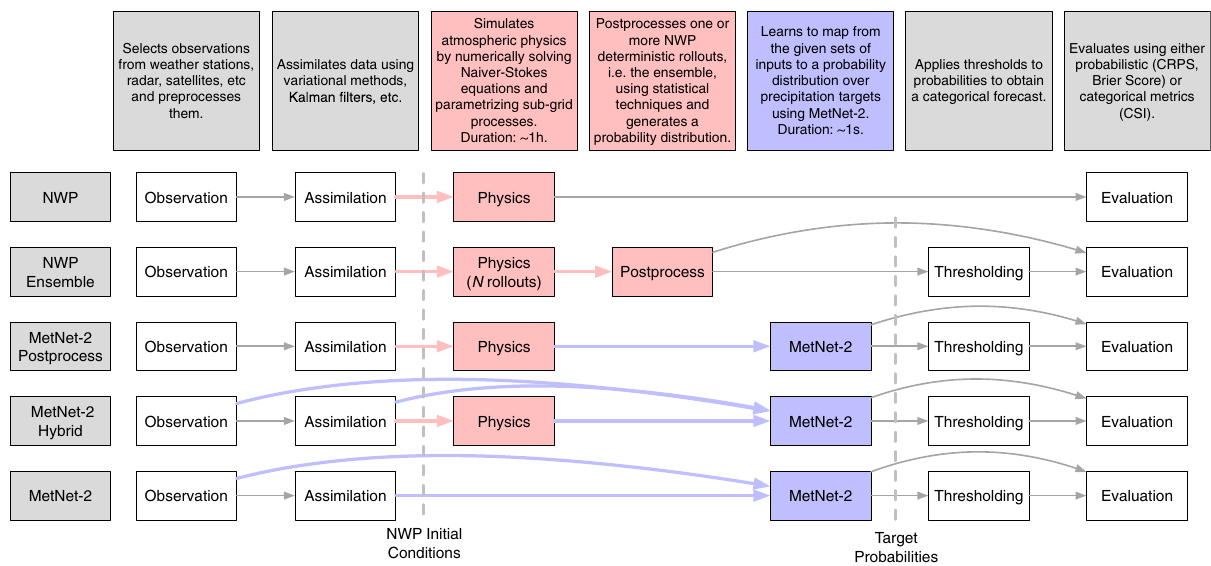
Fig. 1 | Types of Weather Models. Computation stages in a physics-based non- probabilistic NWP model (HRRR), a probabilistic ensemble NWP model (HREF), MetNet-2 and the two MetNet-2 variants. MetNet-2 does not rely on atmospheric simulation, whereasthe othermodels do. The observationand assimilation phases